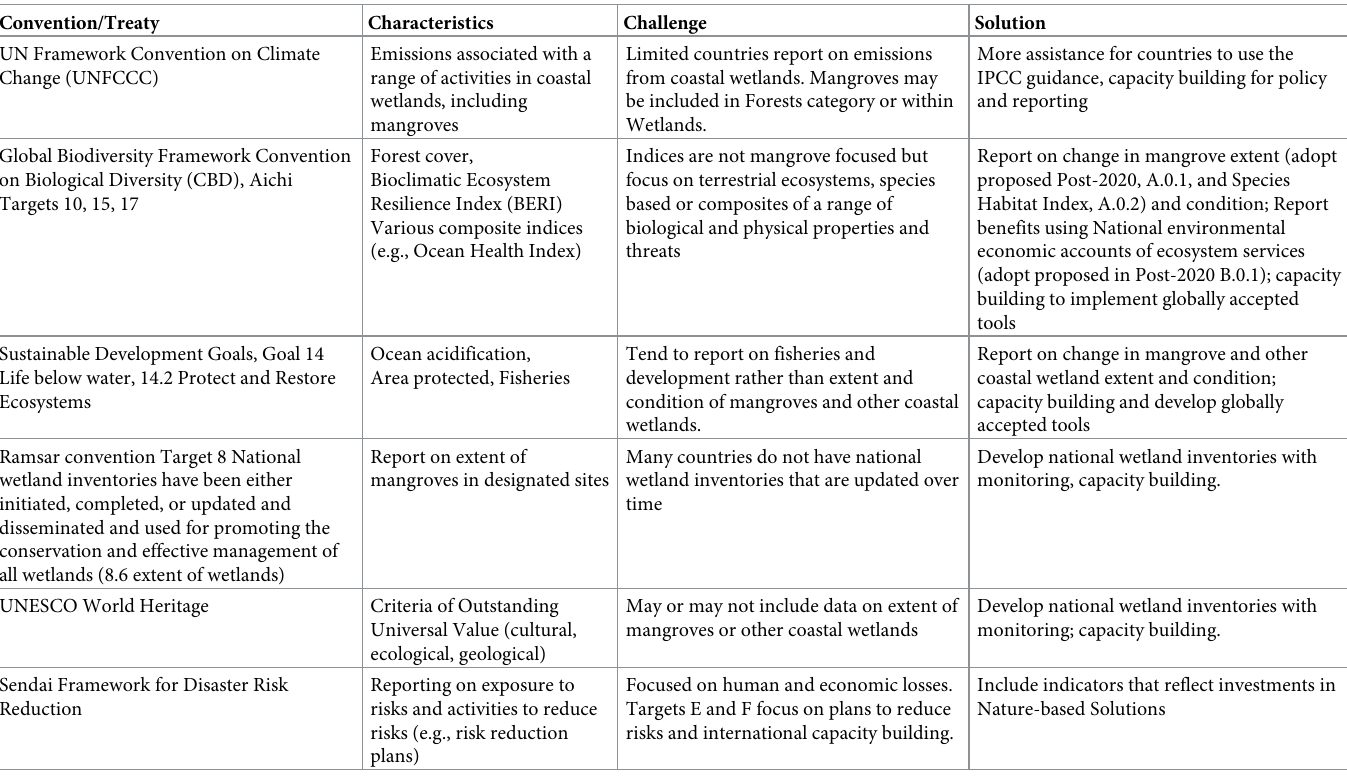
Table 2. National reporting on mangrove restoration or the impacts of mangrove restoration and current challenges in the adequacy of reporting frameworks and potential solutions. Convention/Treaty